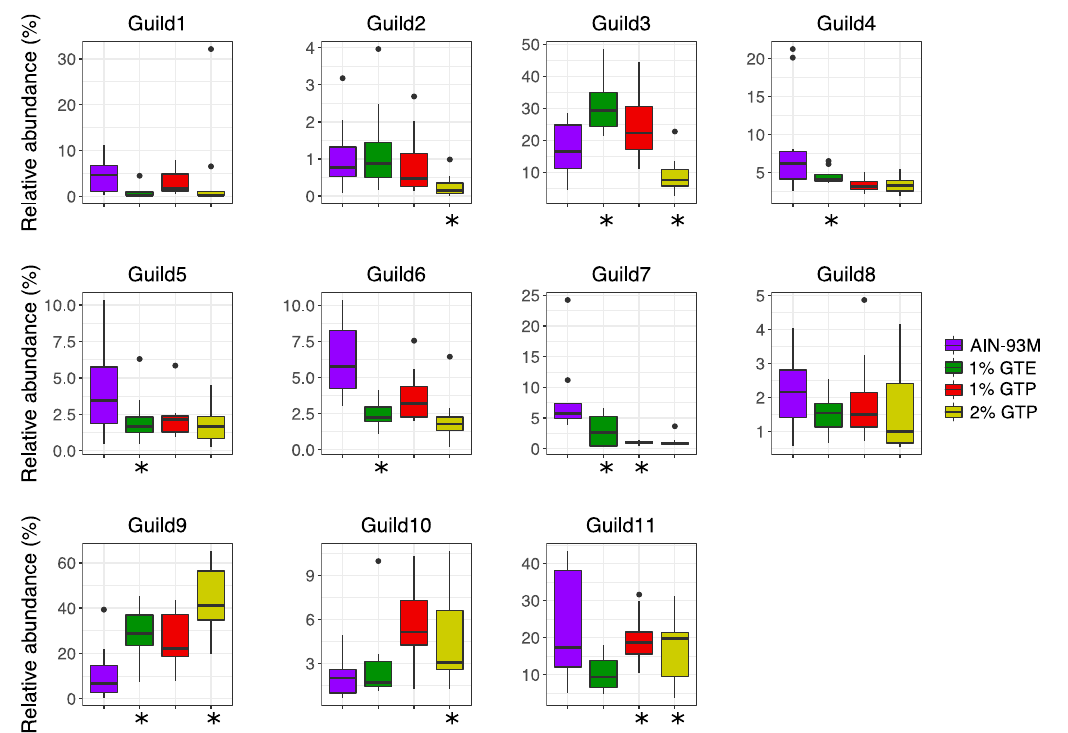
Figure 4. Associations between bacterial guilds and green tea preparations. The AST-transformed relative abundance of the guilds at Day 28 were used. Multivariate association with linear models 2 (MaAsLin2) was applied to explore the association between green tea compound supplements and guilds with adjustment for food and water consumption. Boxes show the medians and the interquartile ranges (IQRs), the whiskers denote the lowest and highest values that were within 1.5 times the IQR from the first and third quartiles, and outliers are shown as individual points. Compared with the db / db AIN-93M group, “*” showed significant difference (adjusted p < 0.25) in each treatment